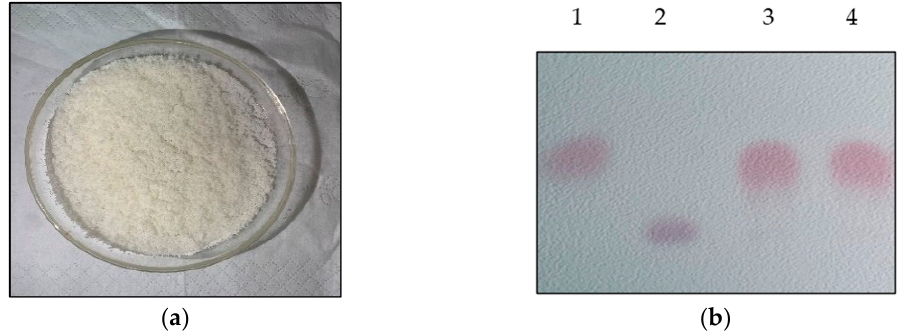
Figure 7. GABA product ( a ) and its pre-staining thin-layer chromatogram ( b ). Lane 1: 1.0 g/L GABA standard; lane 2: 2.0 g/L L-glutamic acid standard; lane 3: purified GABA product; and lane 4: 100-fold dilution of whole-cell reaction broth.